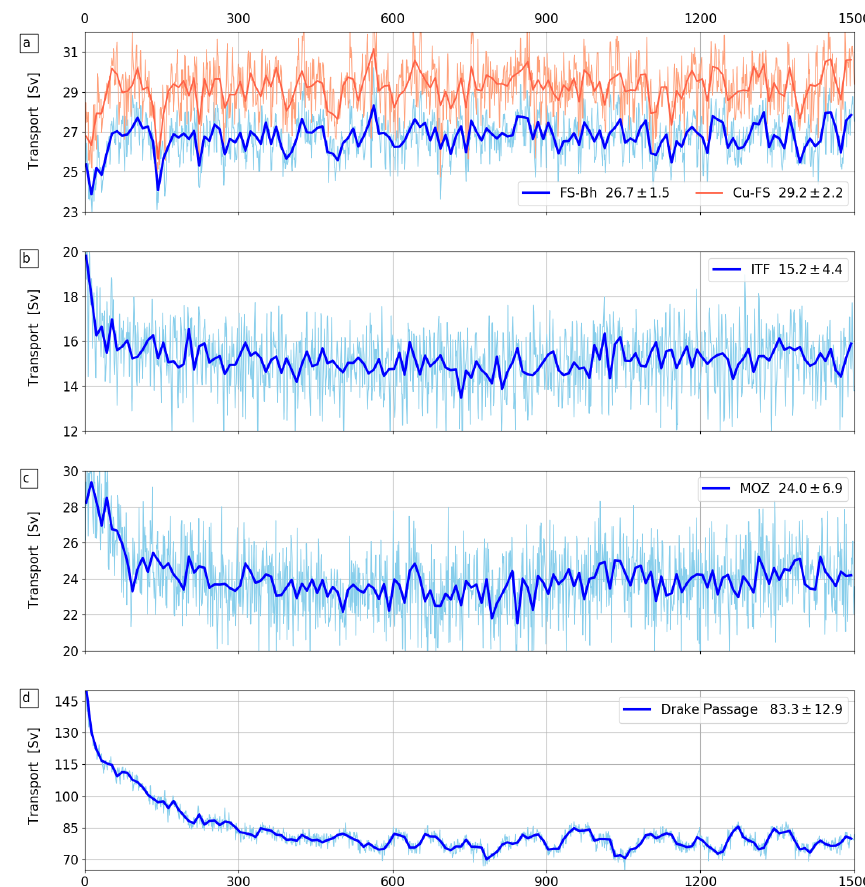
Figure 11. Transport time series (in Sv) from the complete 1500-year reference FOCI-piCtl simulation, across various sections: (a) Florida Straits, between Florida–Bahamas (FS–BH, blue) and Florida–Cuba (Cu–FS, red), (b) the Indonesian archipelago, (c) the Mozambique Channel and (d) the Drake Passage. Sections are highlighted in Fig. 10. Mean and interannual standard deviation for each section are given next to each time series. Light blue indicates annual mean; dark blue indicates 10-year mean